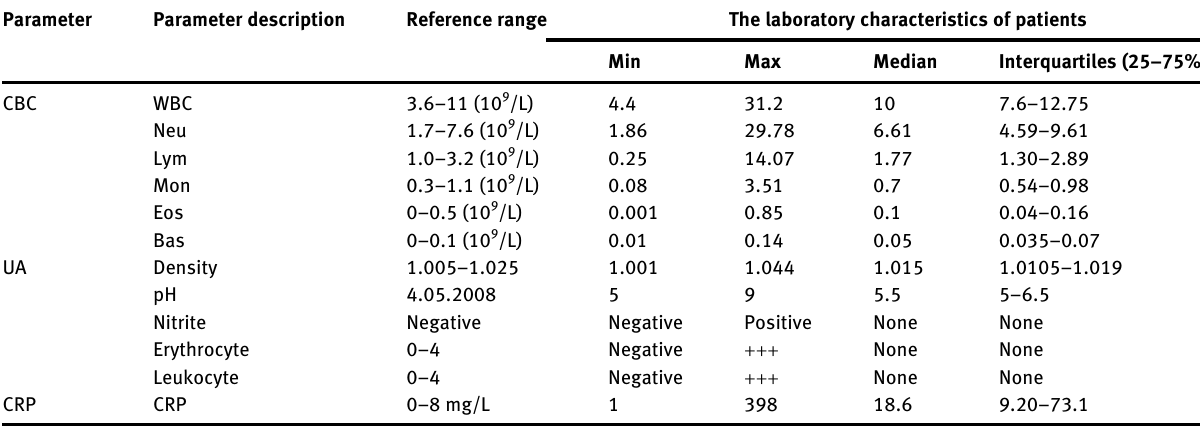
Table  : Parameters used for the analysis and their descriptions, reference ranges and the laboratory characteristics of patients. Parameter